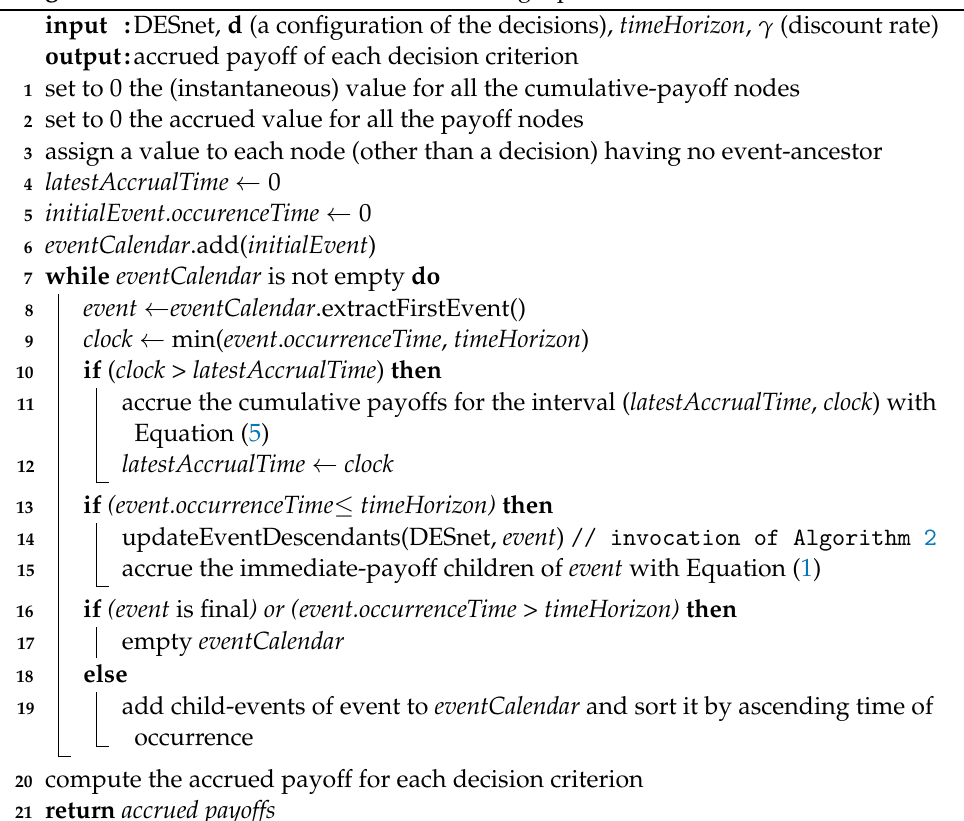
Algorithm 1: Evaluation of a DESnet for a single patient